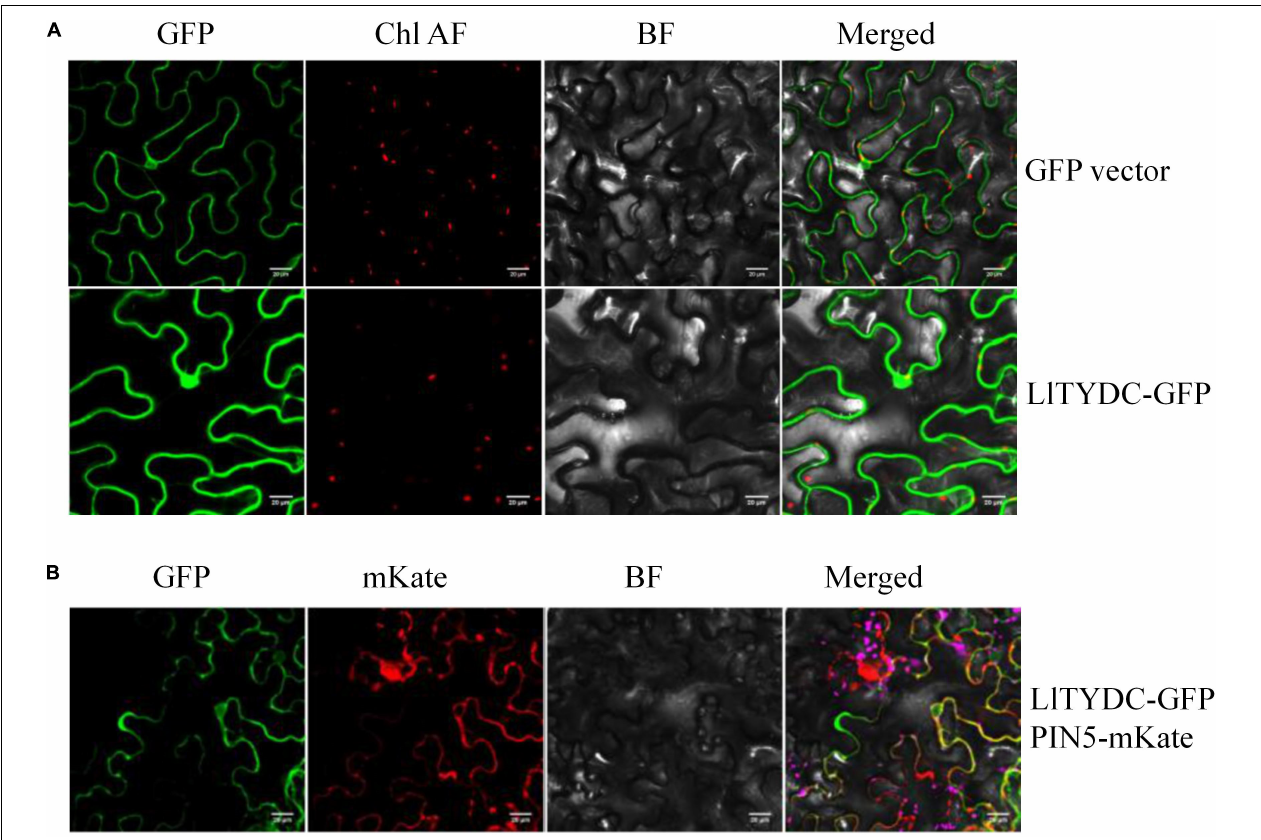
FIGURE 8 | Subcellular localization of LlTYDC. (A) Subcellular localization of GFP alone and LlTYDC-GFP fusion protein in tobacco epidermal cells. (B) Tobacco epidermal cells co-expressing LlTYDC-GFP and an endoplasmic reticulum marker (PIN5-mKate). The photographs were taken in the green channel (GFP fluorescence), red channel (mKate fluorescence), combination of green and red channel, and bright field channel (BF) ( N = 3, Scale bar = 20 µ